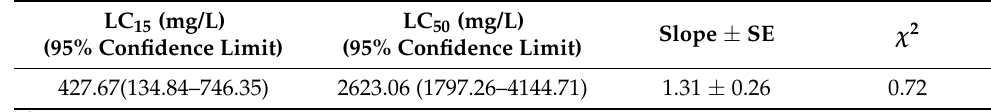
Table 2. Toxicity of C. citratus essential oil on the 2nd-instar larvae of A.